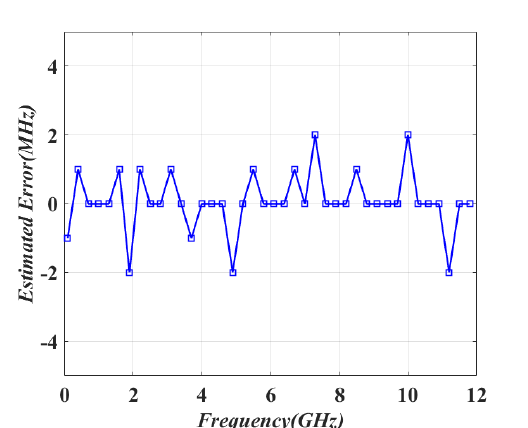
Figure 10. Estimated error with different RF signals over 0.1–12 GHz.